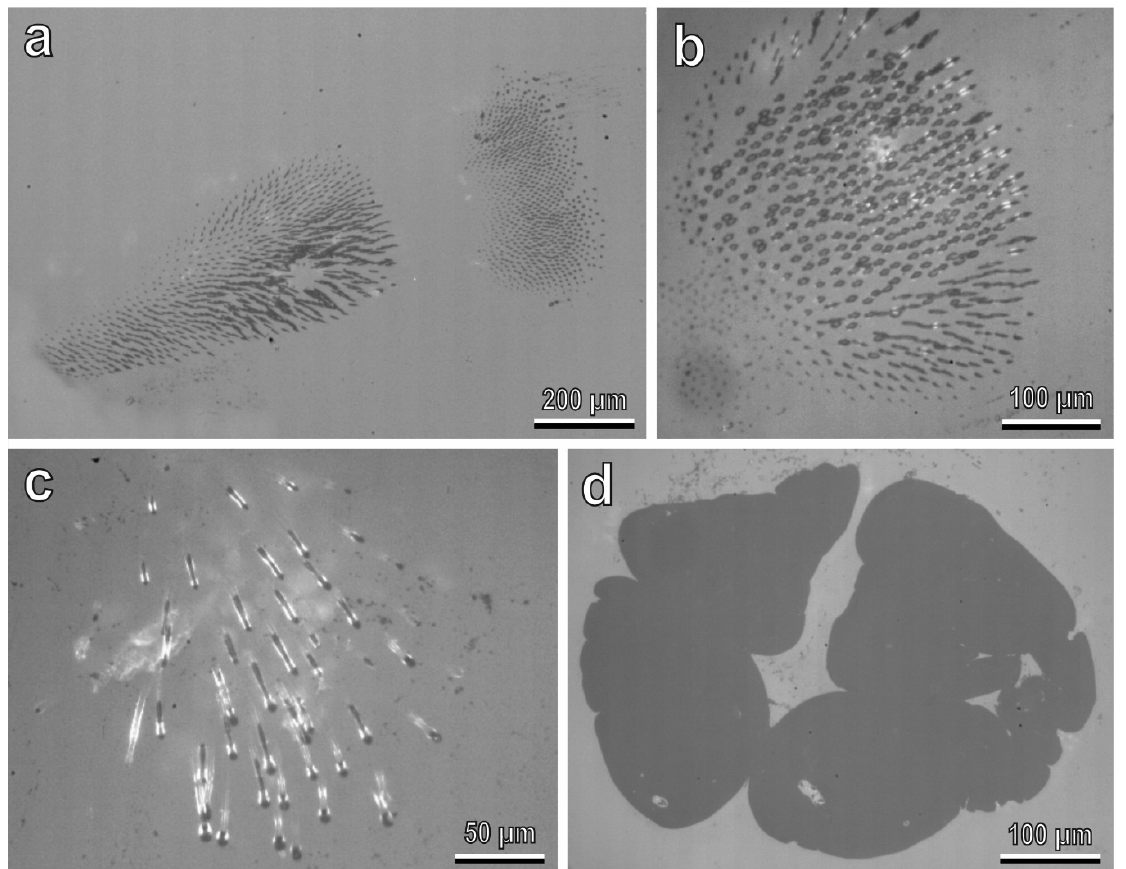
Figure 2. Footprints of females ( a , b ) and larvae ( c , d ) walking on hydrophilic glass, visualized with reflection contrast microscopy and a high-speed camera. The areas of contact between attachment structures and glass appear dark. ( a , b ) Contact area of tenent setae of adhesive pads. ( c ) Contact area of tarsal tenent setae. ( d ) Contact area of pygopodium.